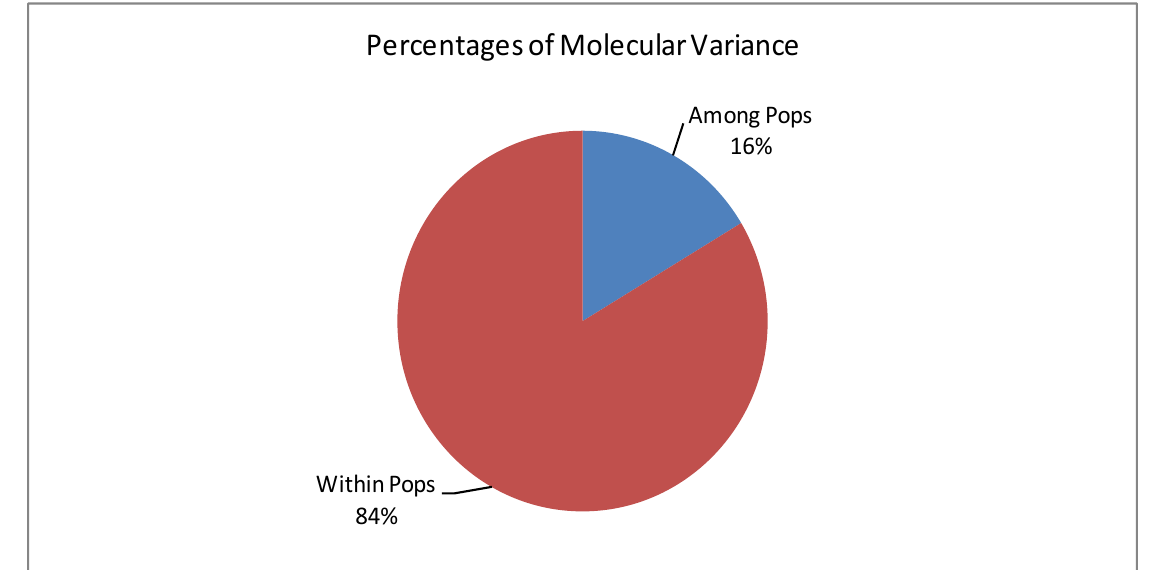
Figure 4. Analysis of Molecular Variance of core members in the two jujube cultivar groups assigned by Structure program.